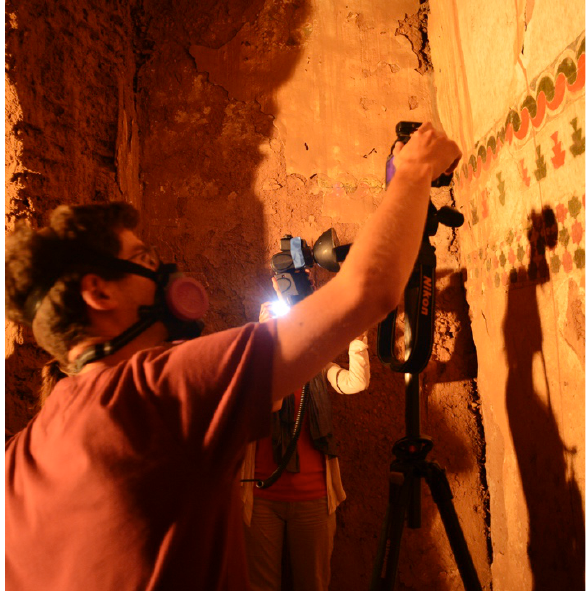
Figure 2: A GCI team member undertaking non-invasive technical imaging.